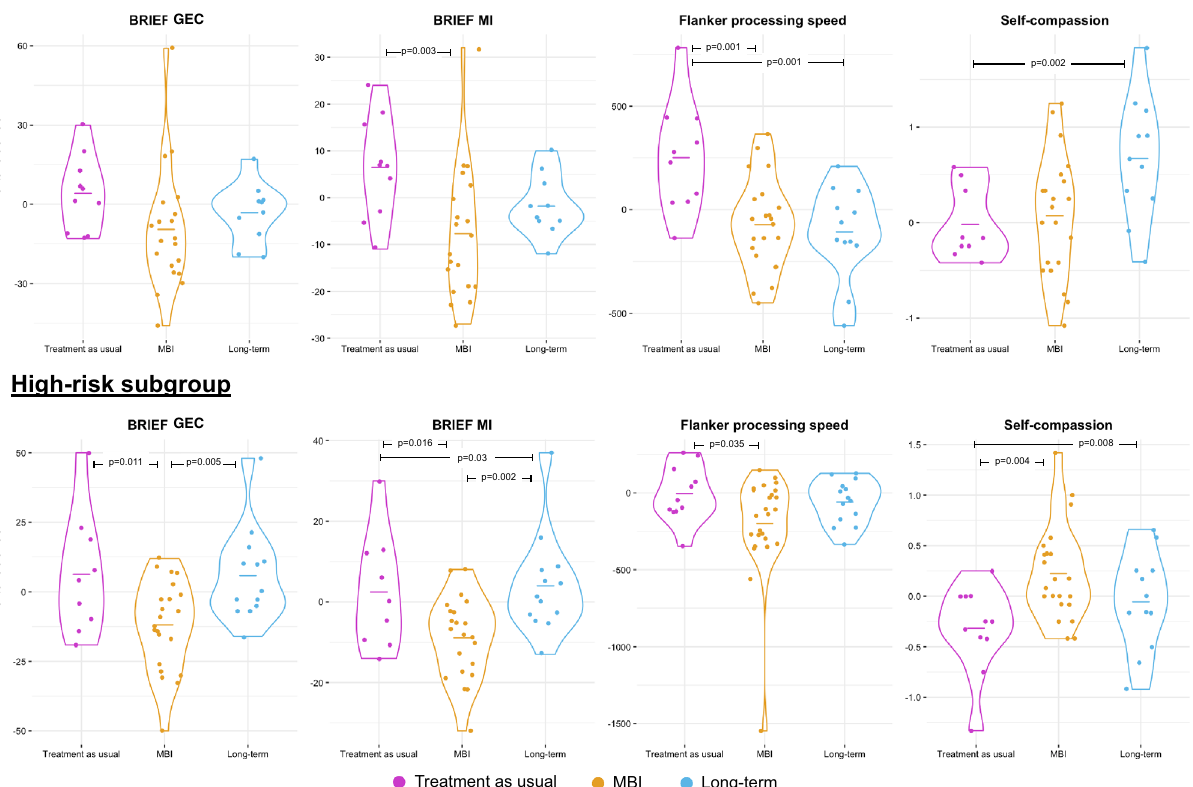
Figure 2. Distribution of the delta scores (Δ) of the “Treatment as usual”, “MBI” and “Long-term” groups for the significant planned contrasts for the two subgroups of VPT: moderate-risk and high-risk. Lines in the violin plots represent the means for each